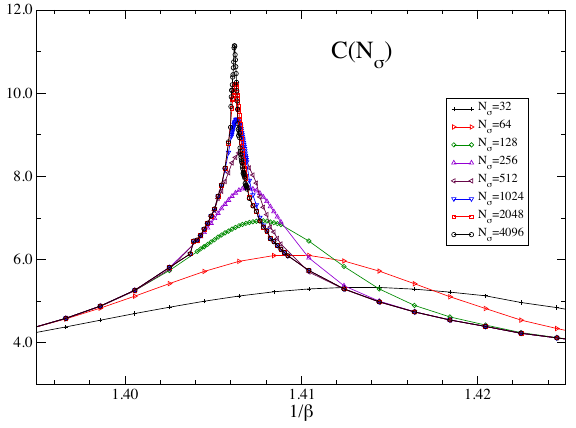
Figure 8 . Speci(cid:12)c heat C ( N (cid:27) ) at N (cid:28) = 3 as a function of 1 =(cid:12) with N (cid:27) 2 [32 ; 4096].